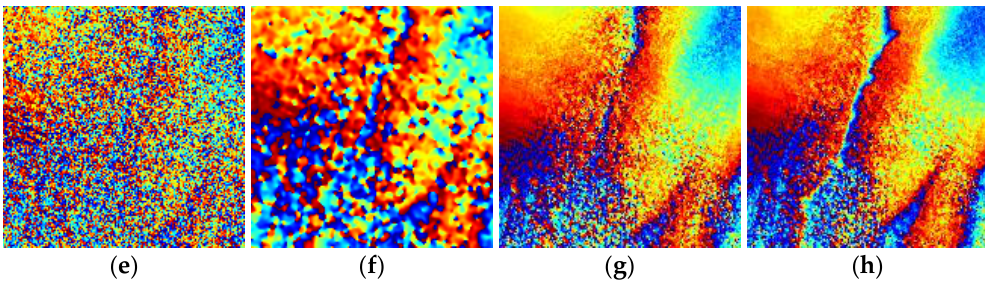
Figure 8. Comparison of the details of three-phase filtering methods showing local details: ( a , e ) original interferogram, ( b , f ) Lee method, ( c , g ) Goldstein method, and ( d , h ) our method.